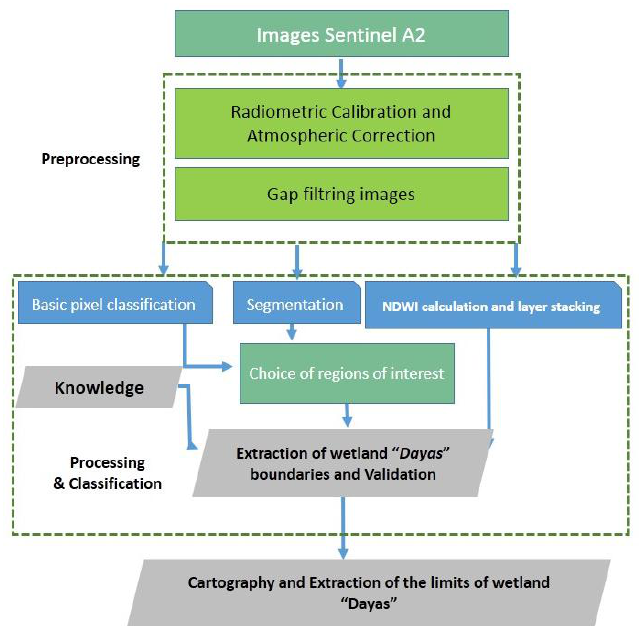
Figure 2. General methodology of